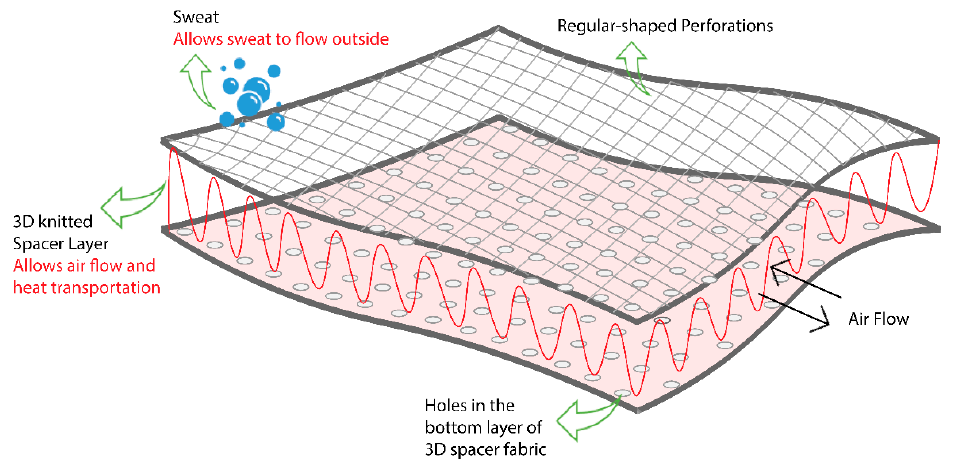
Figure 2. Structural diagram of the 3D knitted spacer substrate.